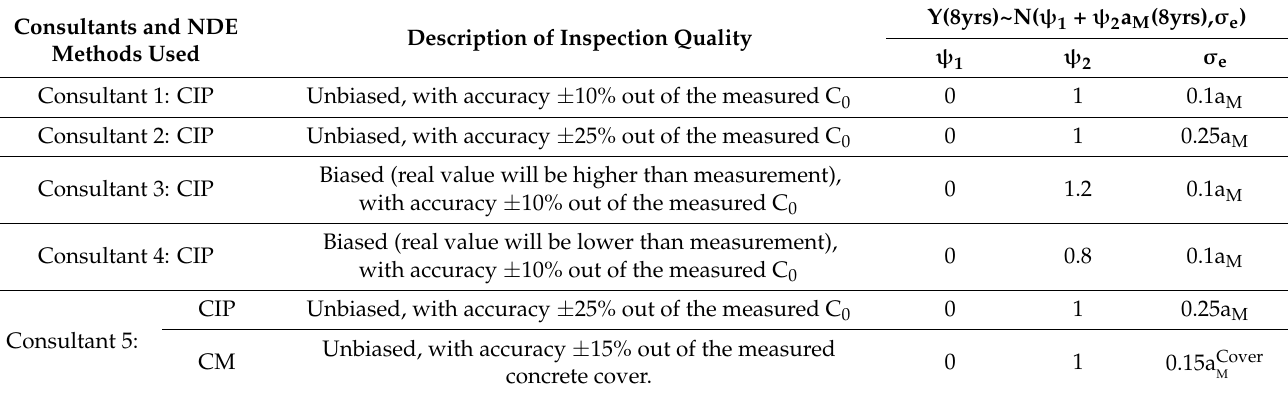
Table 7. Accuracy details of NDE methods proposed by of the five different consultants. Consultants and